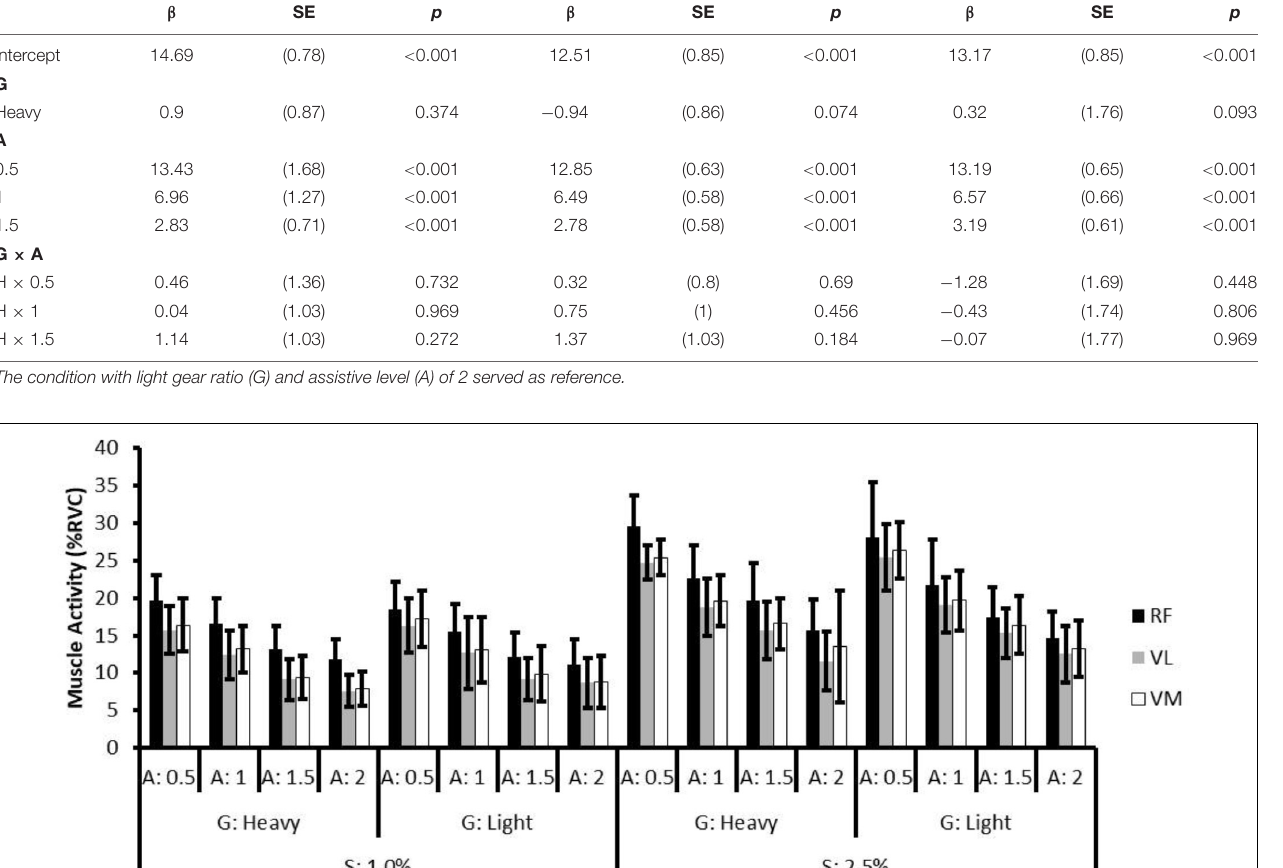
TABLE 4 | Coefficients ( β ), standard errors (SE), and p -values of biomechanics responses in 2.5% slope conditions. RF VL